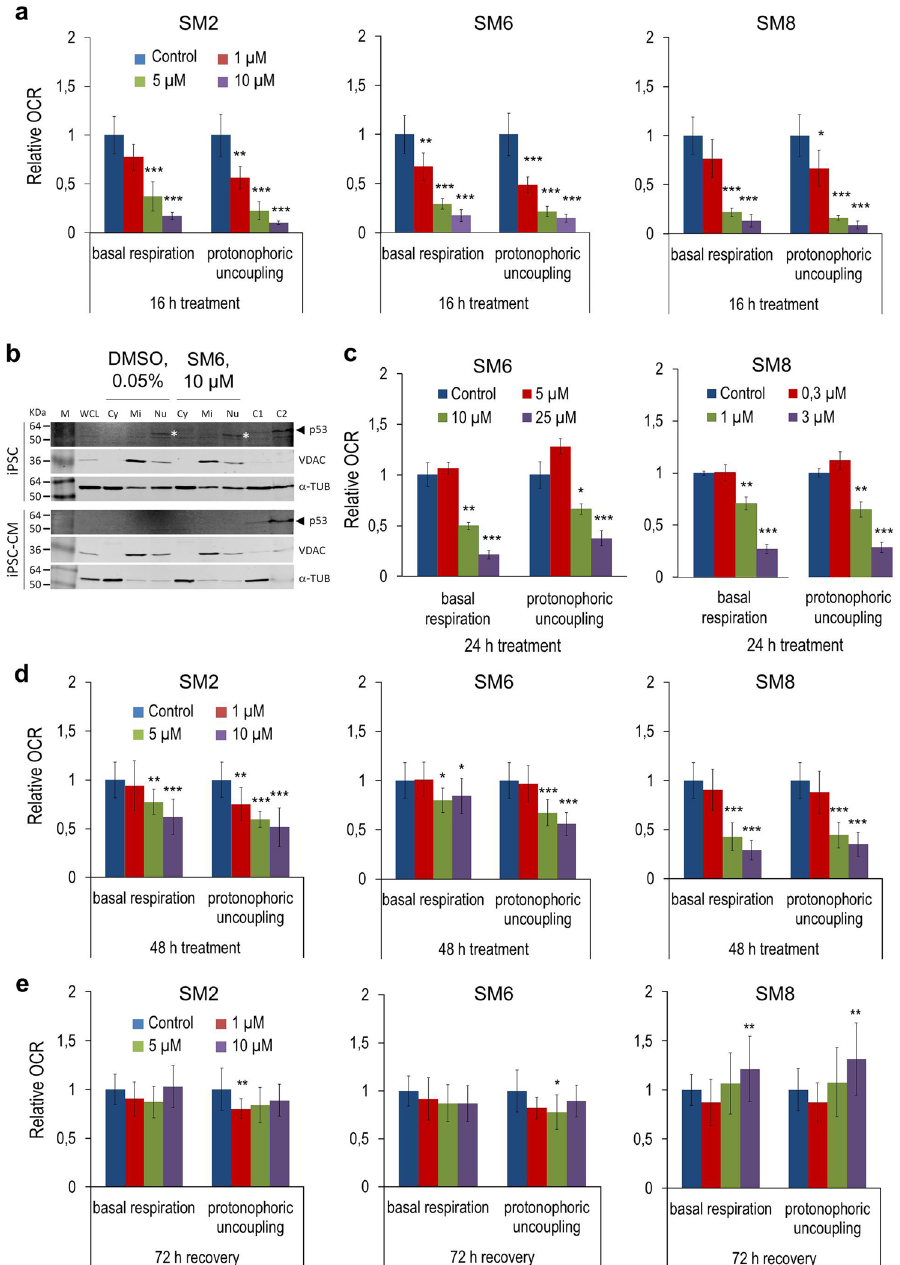
Figure 4. Salicylic diamines inhibit basal respiration and maximal respiratory capacity to a different extent in miPSCs, hiPSCs and miPSC-CMs. ( a , c – e ) Basal respiration and OCR response to FCCP-induced (1 µM) protonophoric uncoupling in undifferentiated αPIG-AT25 miPSCs after 16 h of SM treatment ( a ), in undifferentiated NP0040 hiPSCs after 24 h of treatment ( c ) and in purified miPSC-CMs after 48 h of SM treatment ( d ) as well as after 72 h of recovery following treatment ( e ). Data are shown as relative values compared to 0.05% DMSO-treated control cells and are presented as mean ± SD of n = 3 measurements from one experiment in ( a and c ), and n = 6 measurements pooled from two independent experiments in d and e. Each measurement was performed with 7 replicates per group. See also Supplementary Fig. S5. ( b ) Immunoblot analysis. miPSCs and miPSC-CMs were treated with 10 µM SM6 or vehicle (0.05% DMSO) for 8 h and then fractionated into cytoplasmic (Cy), mitochondrial (Mi) and nuclear (Nu) fractions. Levels of p53, cytosolic marker α-tubulin (α-TUB), and mitochondrial marker voltage-dependent anion channel (VDAC) were determined in each fraction and compared with those from whole cell lysates (WCL) by immunoblotting. C1 and C2 indicate control WCLs prepared from, respectively, human HEK293 and HT29 cells in the panel for iPSCs, and HEK293 and COS9 cells in the panel for iPSC-CMs. They served as positive controls for p53. Molecular weight of human p53 is slightly higher than that of murine p53 which explains different positions of this protein in murine iPSC and iPSC-CM (*) and human control samples in C1 and C2 lanes ( ◄ ). Full-length immunoblots of all analyses are shown in Supplementary Figs. S8, S9 and S10. KDa kilodalton, M protein